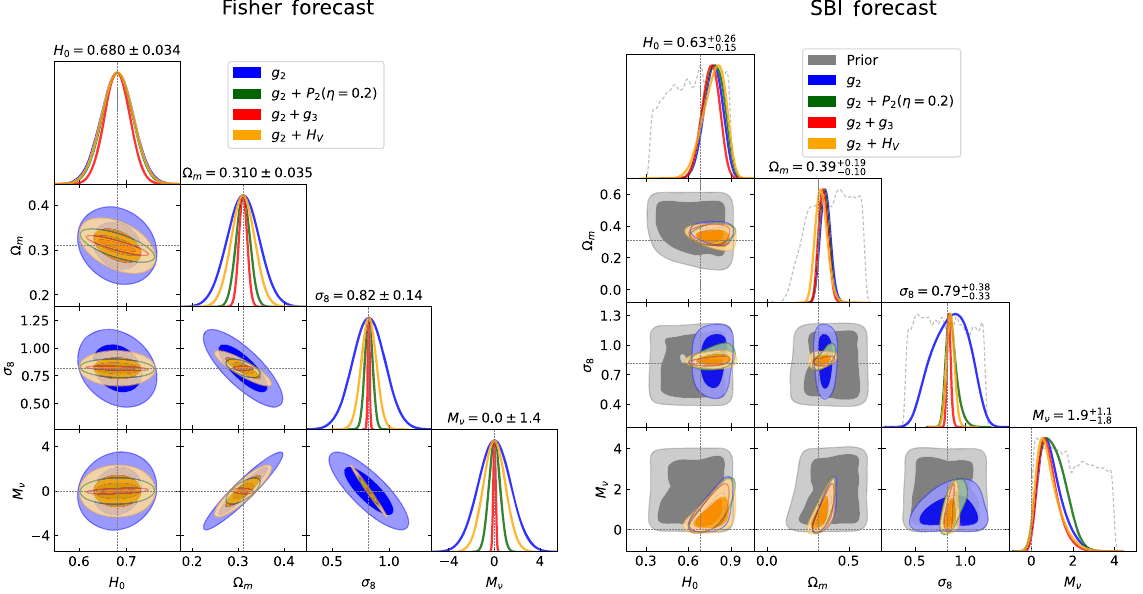
FIG. 13. As Fig. 12 but comparing the constraining power from the combination of the pair correlation function with the pair- connectedness function (green), the three-particle correlation function (red), and the void nearest-neighbor function (yellow). The pair- connectedness function and void nearest-neighbor functions are found to perform almost as well as the three-particle function in this scenario (in terms of constraining σ 8 ) and are much faster to compute and